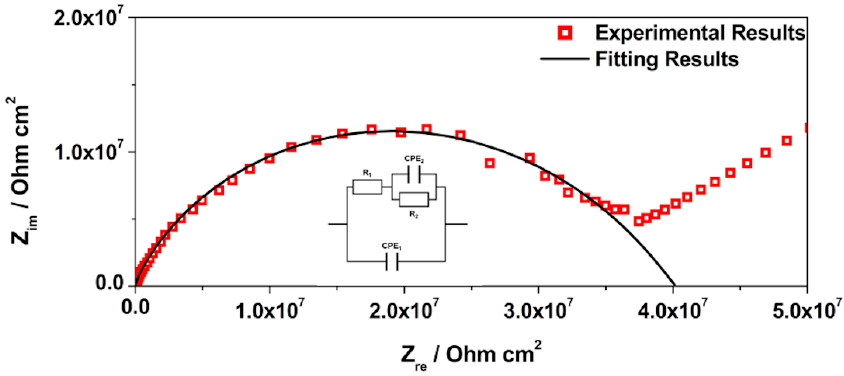
Figure 7. Nyquist plot for pure OIH AES(800)-1/5.